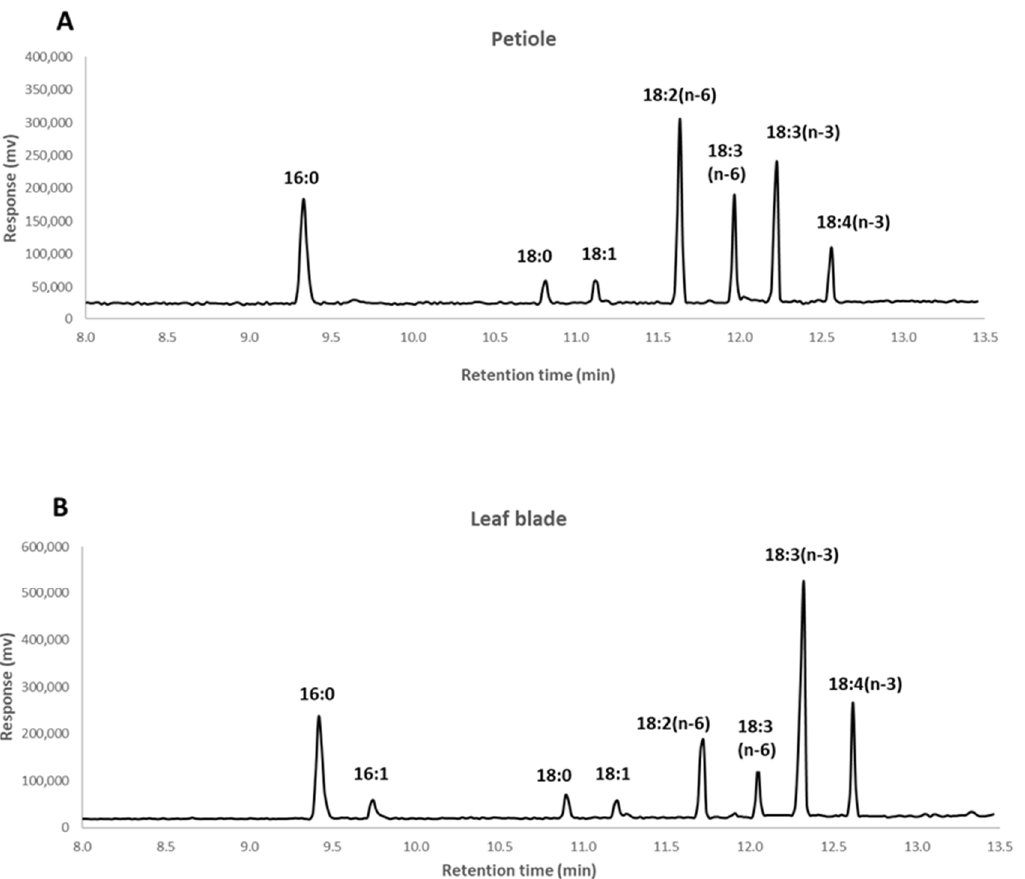
Figure 1. Representative chromatogram of fatty acid methyl esters from the lipid extract of petiole (( A ), corresponding to sample: BL-RI_120das) and leaf blade (( B ), corresponding to sample: BL-RI_150das) of borage, using gas chromatography.